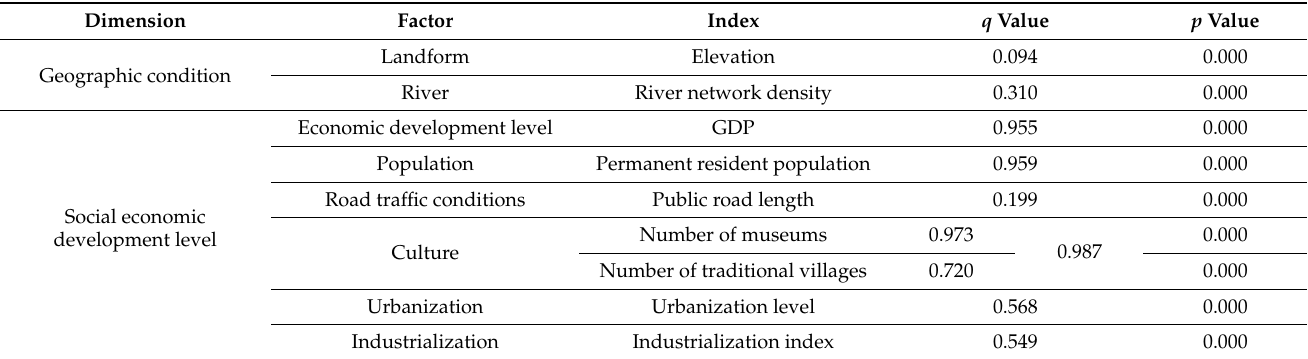
Table 3. Factors influencing spatial distribution of intangible cultural heritage (ICH) and their explanatory